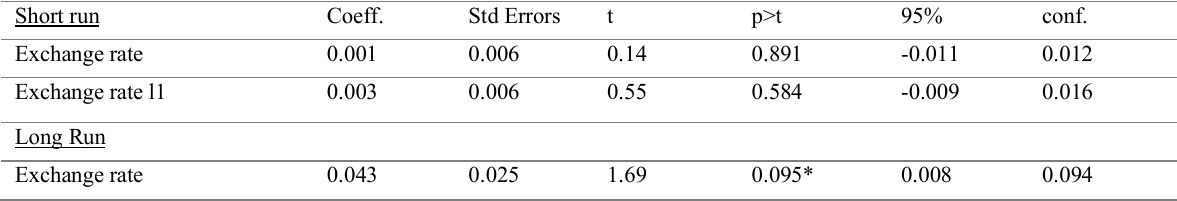
Table 10: Regression results for exchange rate on capital